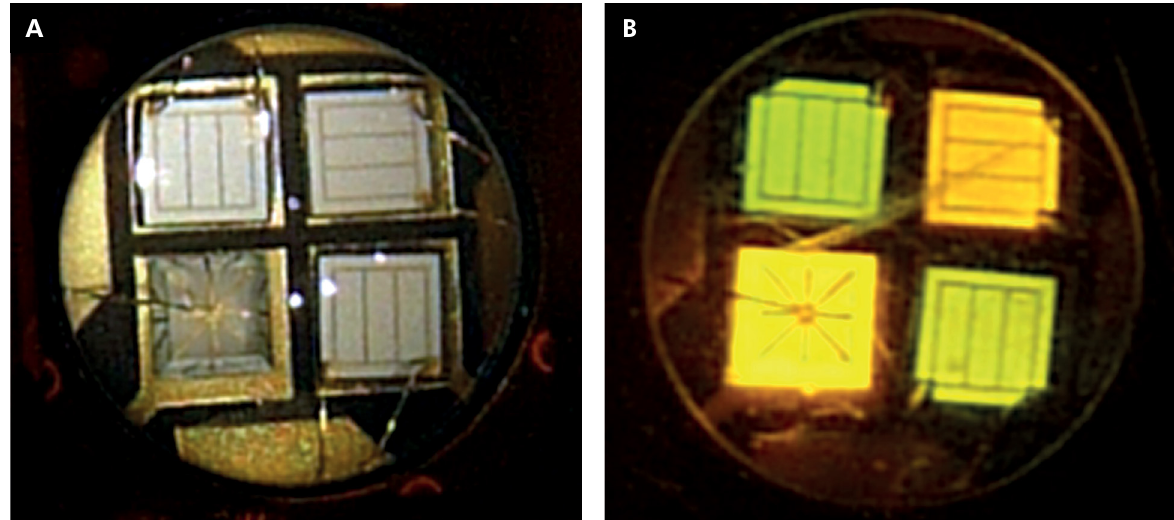
Figure 31. Image of the construction of the emitting elements in Ultradent’s VALO curing light: (a) chips off (B) chips on.